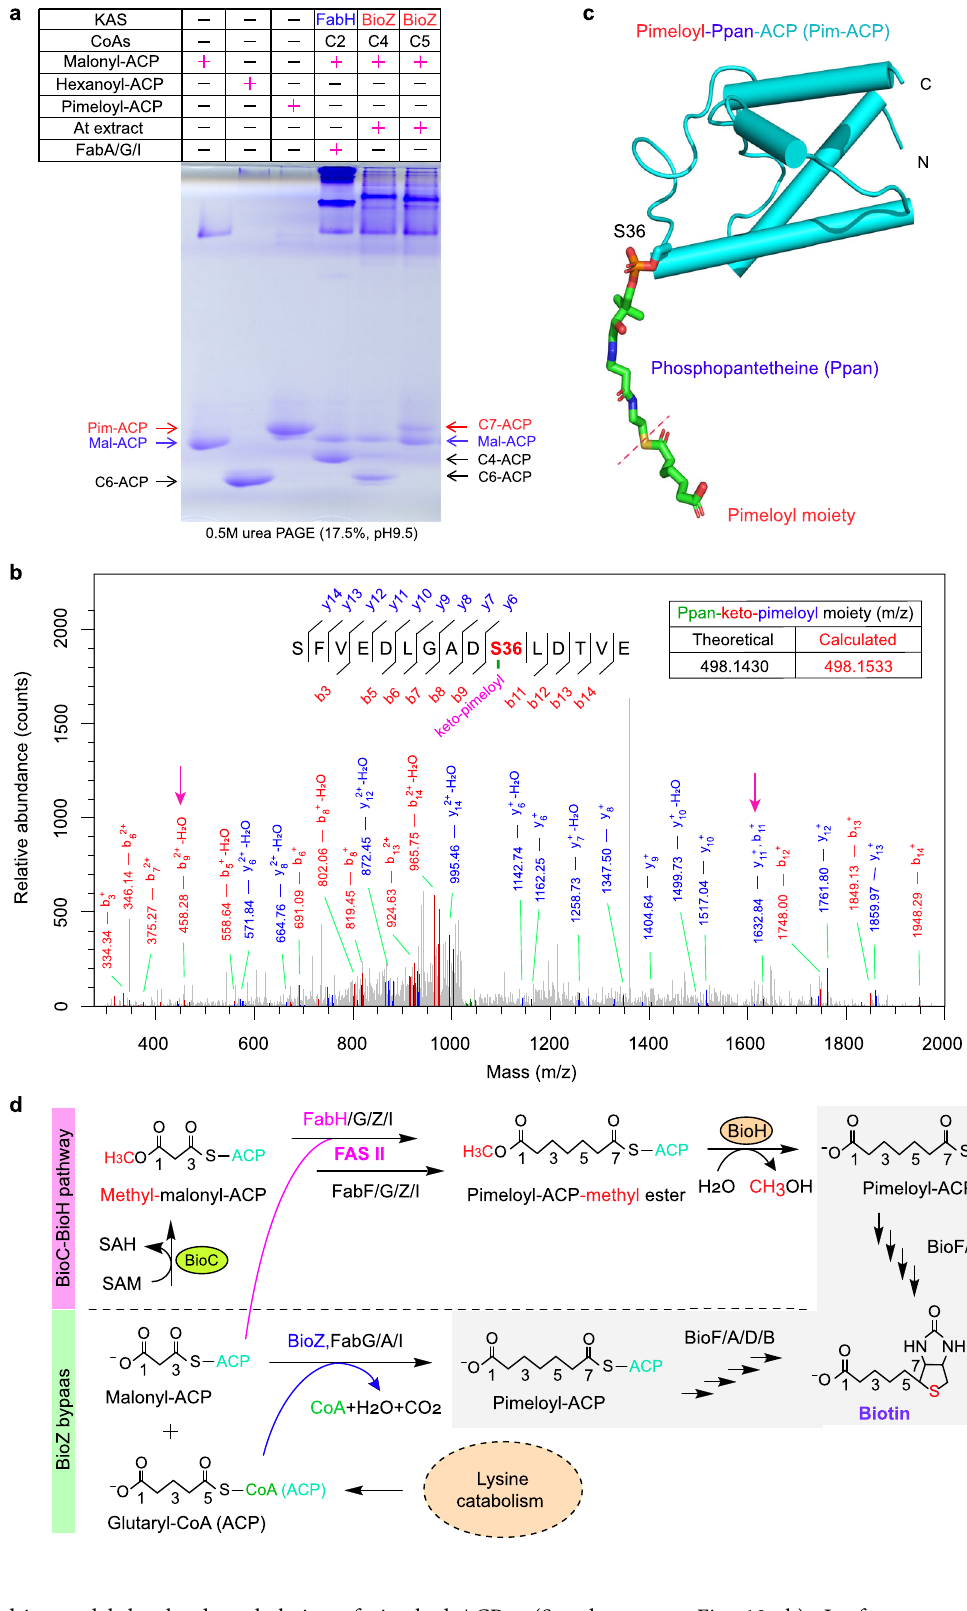
(Supplementary Fig. 10a-b). In fact, our result of isothermal titration calorimetry (ITC) veri fi ed ef fi cient binding of BioZ to glutaryl-ACP with the stoichiometry of N = 0.978 ± 0.028 and Kd = 6.167 ± 0.068 μ M (Supplementary Fig. 11). This might